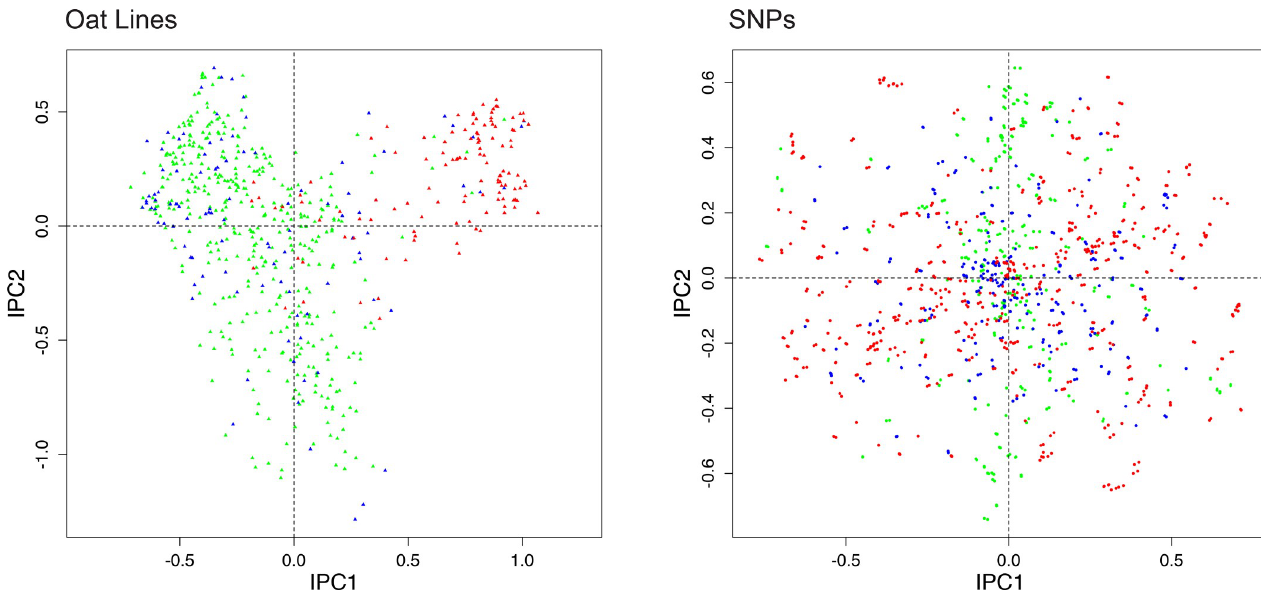
Fig 5. DC-PCA biplot for the oat data, using SNP coding mixed, namely the received data. The color scheme is the same as in Fig 1, namely spring oats show in green, world diversity oats in blue, and winter oats in red, with corresponding colors for the SNPs. The contrast between spring and winter oats is clear for Individuals in the left panel, but the corresponding pattern for SNPs in the right panel has been obliterated by thorough intermixing of the three colors of points.